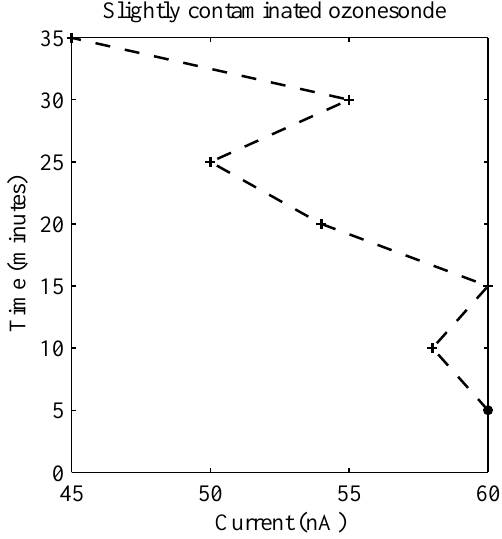
Figure A1. Current measured at each pressure for the contaminated ozonesonde. The dashed line shows the order in which the mea- surements were taken, starting from (1000hPa, 160nA) (the • data point).